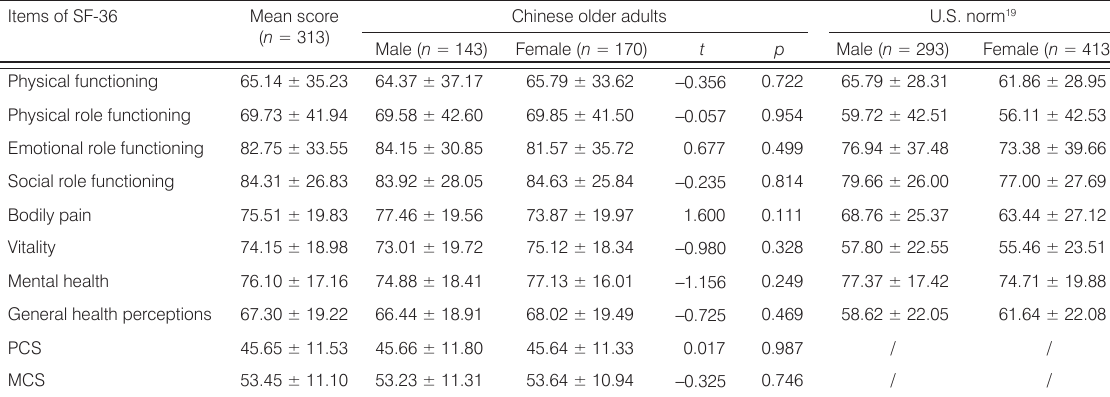
Table 2. Mean SF-36 scales score by